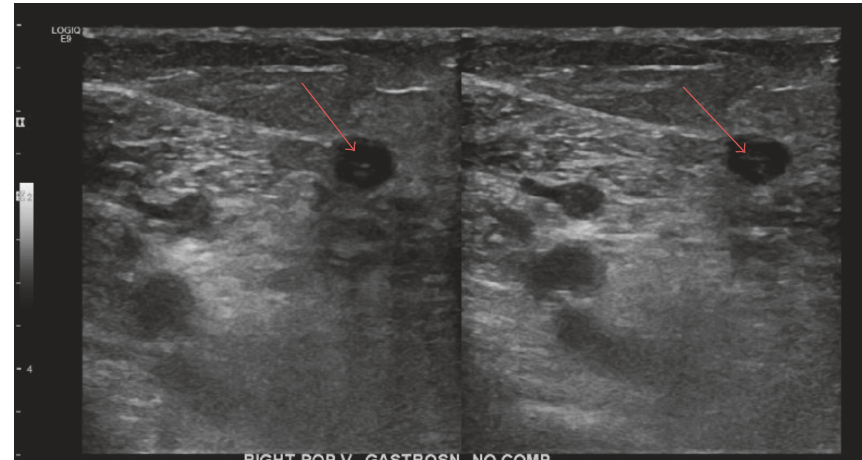
Figure 2: Ultrasound of the right lower extremity showing noncompression of the right popliteal vein as well as a visible thrombus in the lumen (red